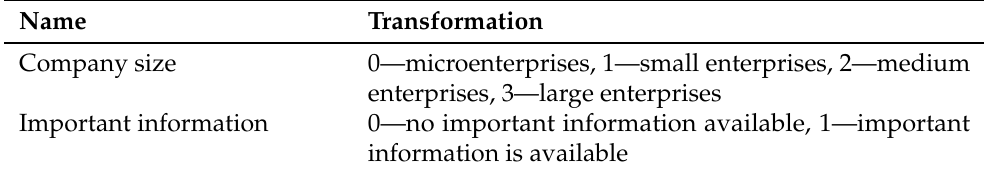
Table 5. Converting data to text format to the numeric